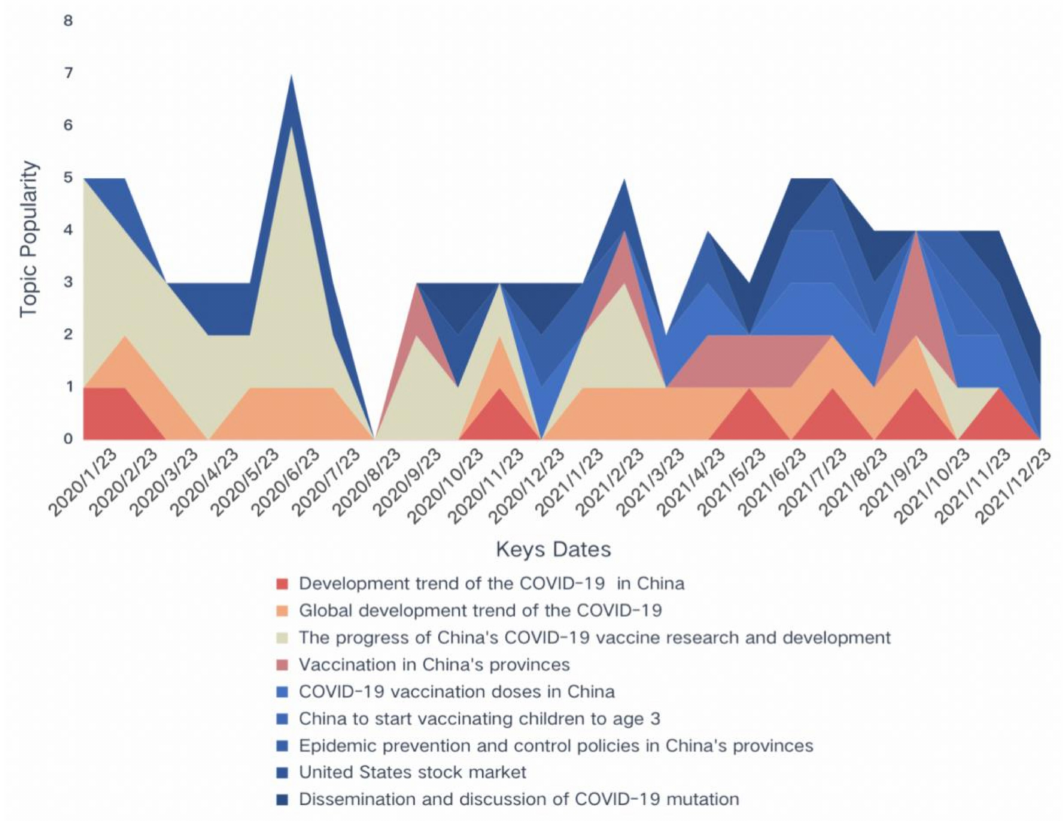
Figure 6. Dynamic distribution of the nine most popular topics over the entire study